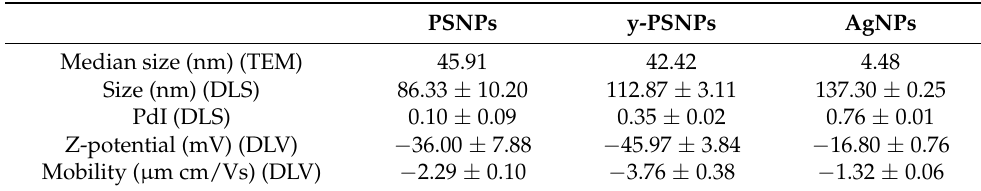
Table 1. PS nanomaterials and AgNPs characterization by TEM (median size) and Zetasizer Nano ZS (mean ± SD).